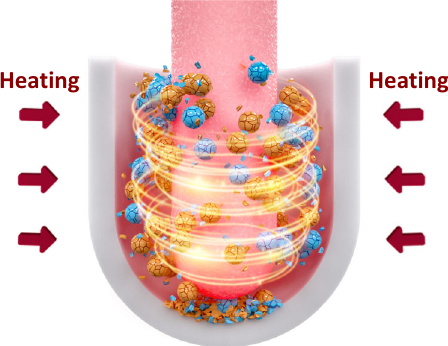
Fig. 1 Schematic representation of the mechano-thermal reactor for preparing 1T-IrO 2 , where the mechanical and thermal operations are controlled simultaneously. The blue and yellow balls indicate IrCl 3 and KOH,